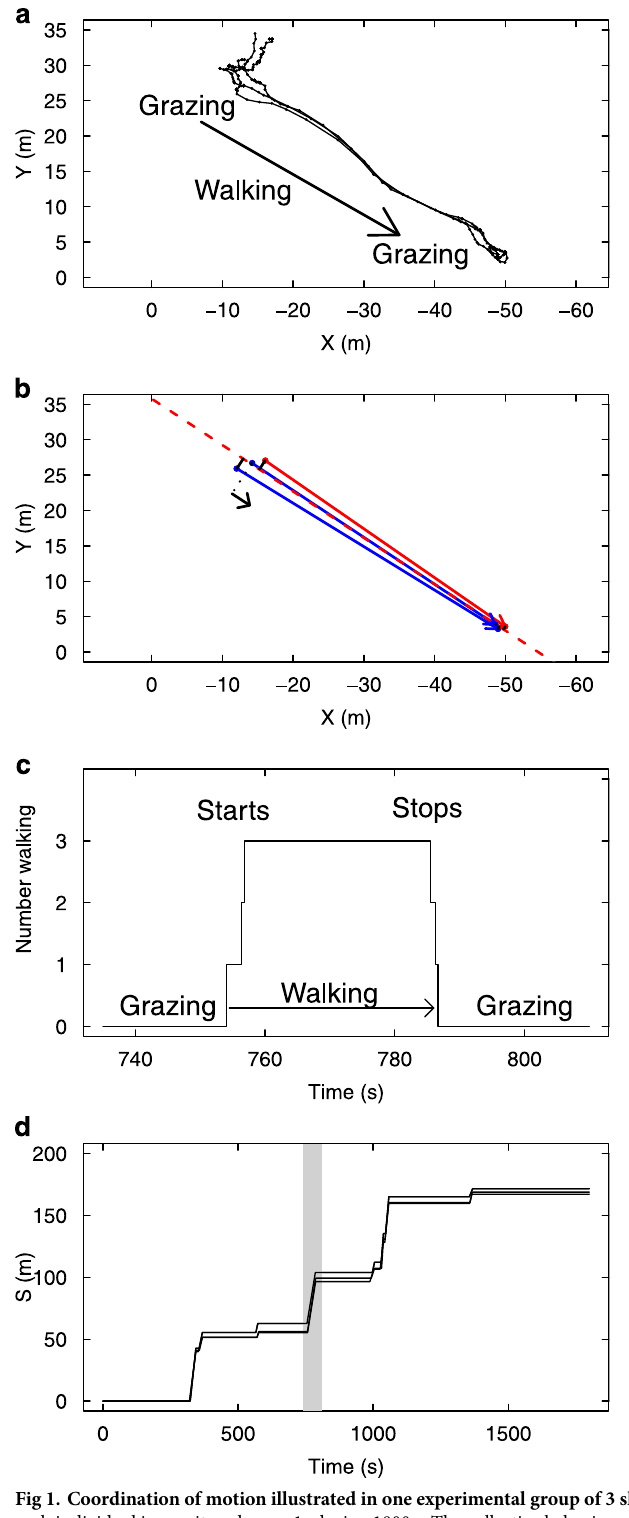
Fig 1. Coordination of motion illustrated in one experimental group of 3 sheep. The position and behaviour of each individual is monitored every 1s during 1800 s. The collective behaviour can be categorised as periods of collective grazing (individuals are about motionless) interspersed by periods of collective walking (high speed motion). (a) An extract of 70 s shows a typical event of collective transition from grazing to walking, leading to a spatial shift of